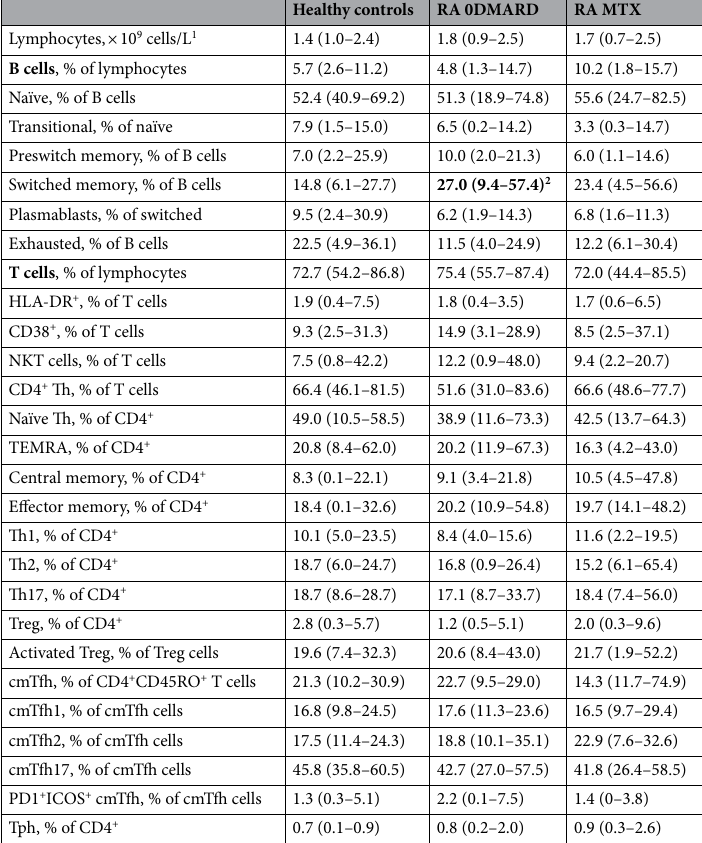
Table 2. Total lymphocytes and B and T cells with subsets at baseline. 1 All results are presented as median (range). 2 Switched memory B cells were higher in RA 0DMARD and all RA patients compared to HC ( p < 0.01 and p =